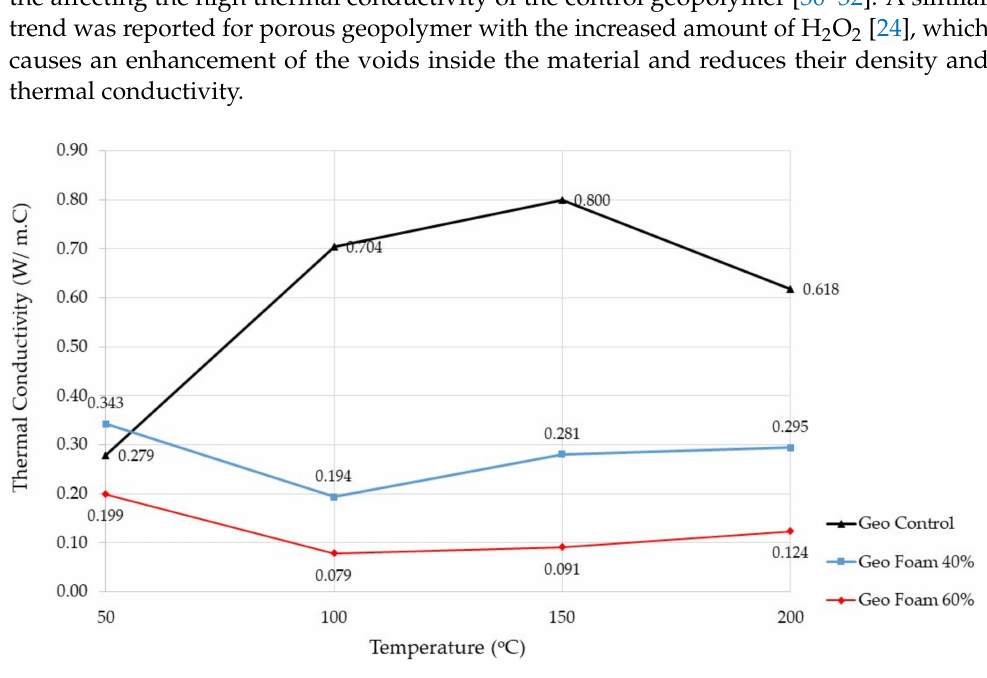
Figure 9. Thermal conductivity of foamed